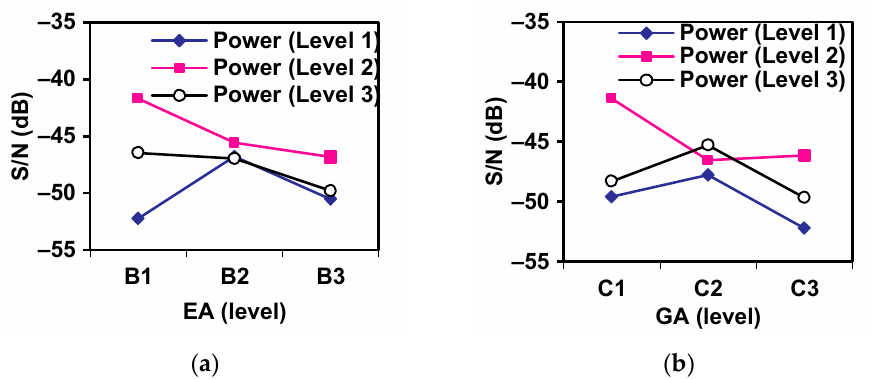
12 Figure 6. Individual influence of factors on the response (CO) S/N obtained for the three leves of ( a ) Power ( b ) Excess Air ( c ) Grate Area ( d ) Split Ratio. Figure 7 presents the interaction between all parameters on CO emission. From its analysis one can identify that there is an important interaction between middle power and